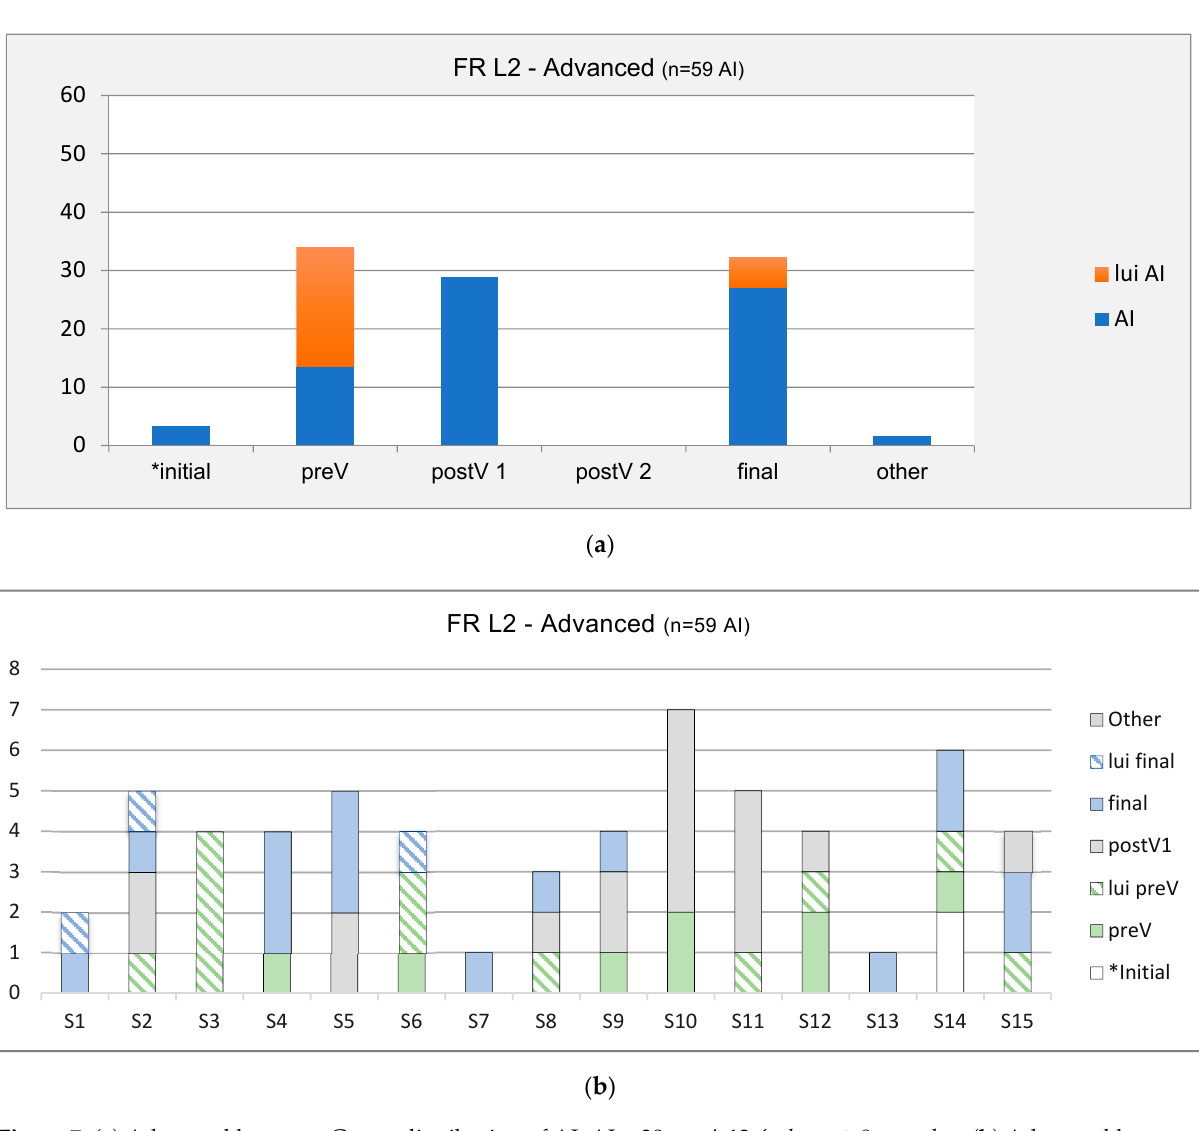
Figure 7. ( a ) Advanced learners: Group distribution of AI. AI = 38 aussi , 12 également , 9 non plus. ( b ) Advanced learners: individual distribution of AI (* = agrammatical position in the TL).